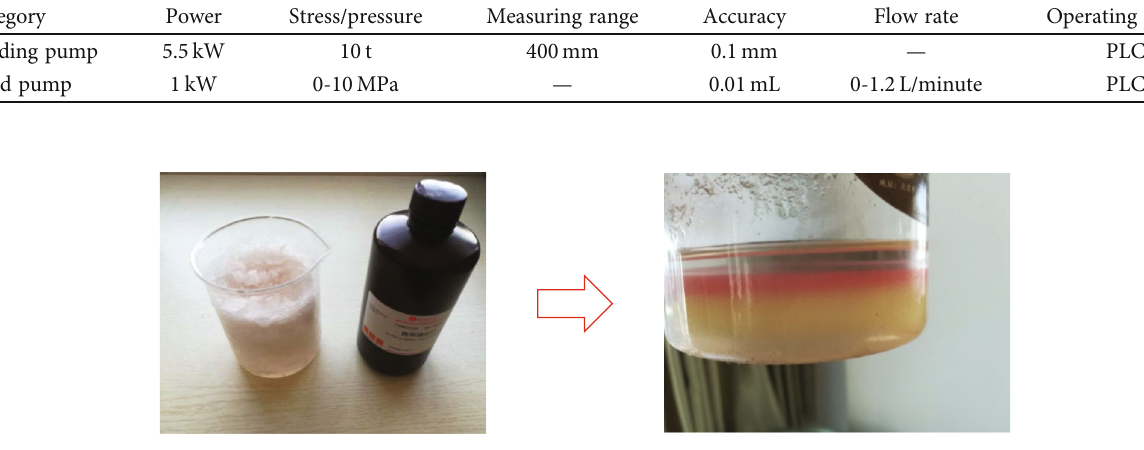
Figure 4: Preparation of the leaching solution.